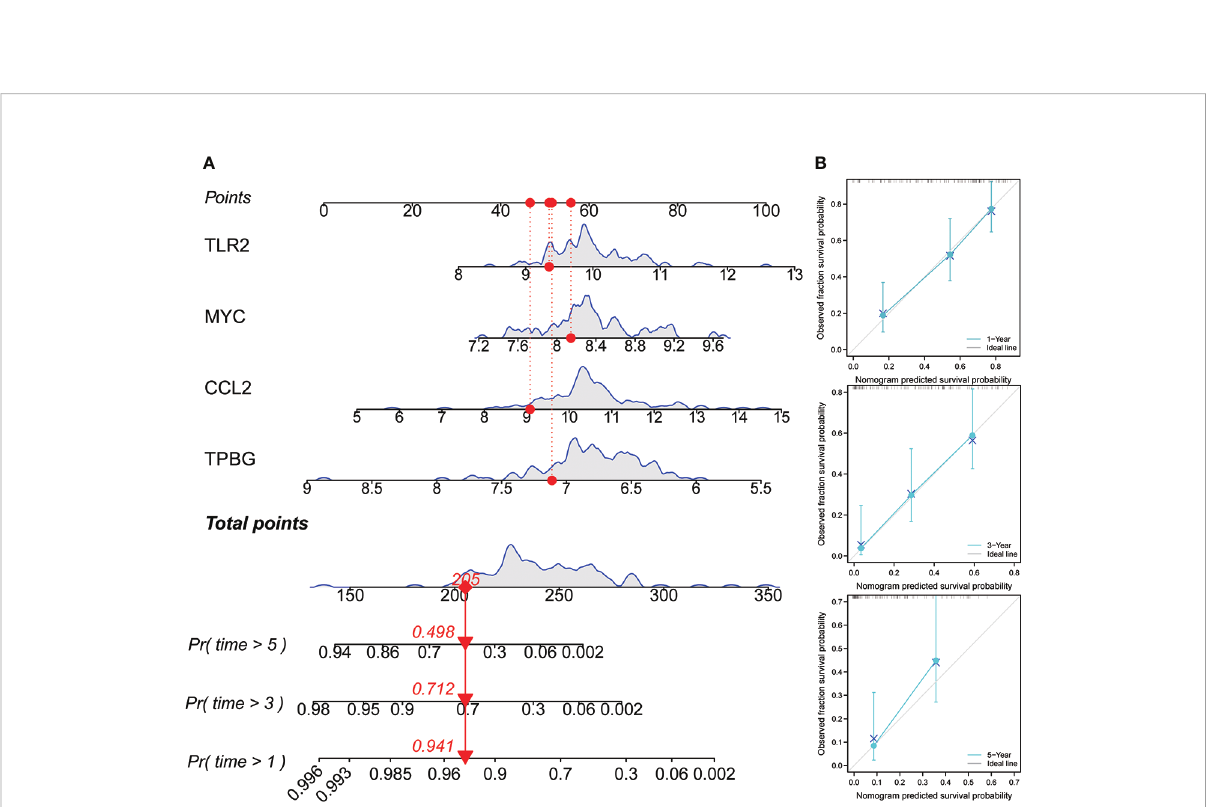
FIGURE 8 Construction and evaluation of nomogram. (A) Nomogram was constructed based on the expression values of four genes to predict the OS rate at 1, 3, and 5 years. (B) The calibration curve was used to assess the